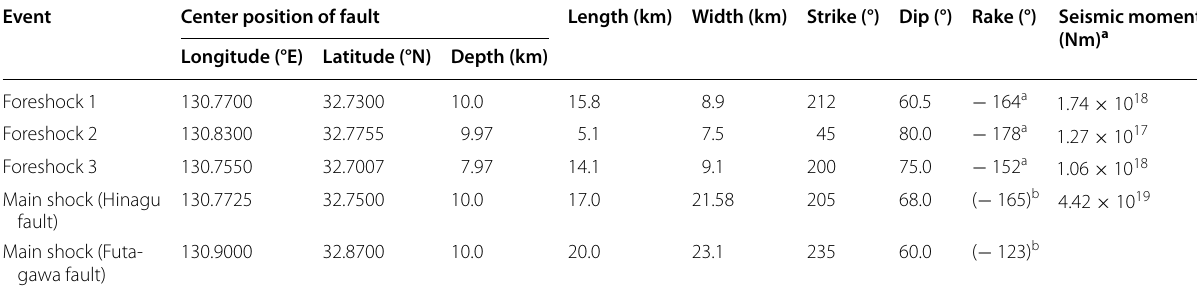
a The values were derived from the F-net moment tensor solutions b These values were calculated from the regional stress field. The slip direction of the main shock in dynamic rupture simulations is the same as the shear stress direction determined from the regional stress field, the static stress change due to the foreshocks, and the dynamic stress change during the rupture propagation